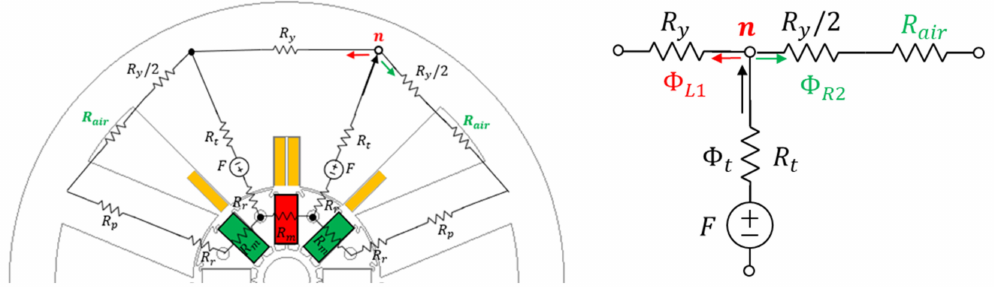
Figure 18. ( a ) MEC model of magnetization, ( b ) Simplified MEC model.